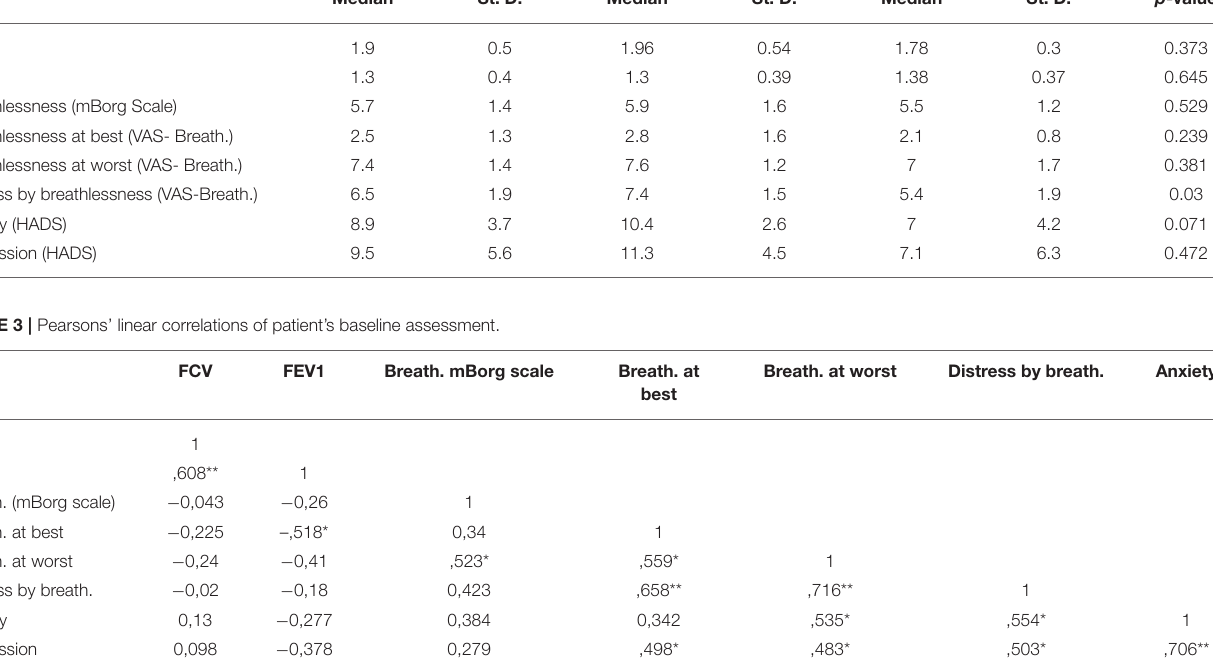
( n = 19) Median St. D.